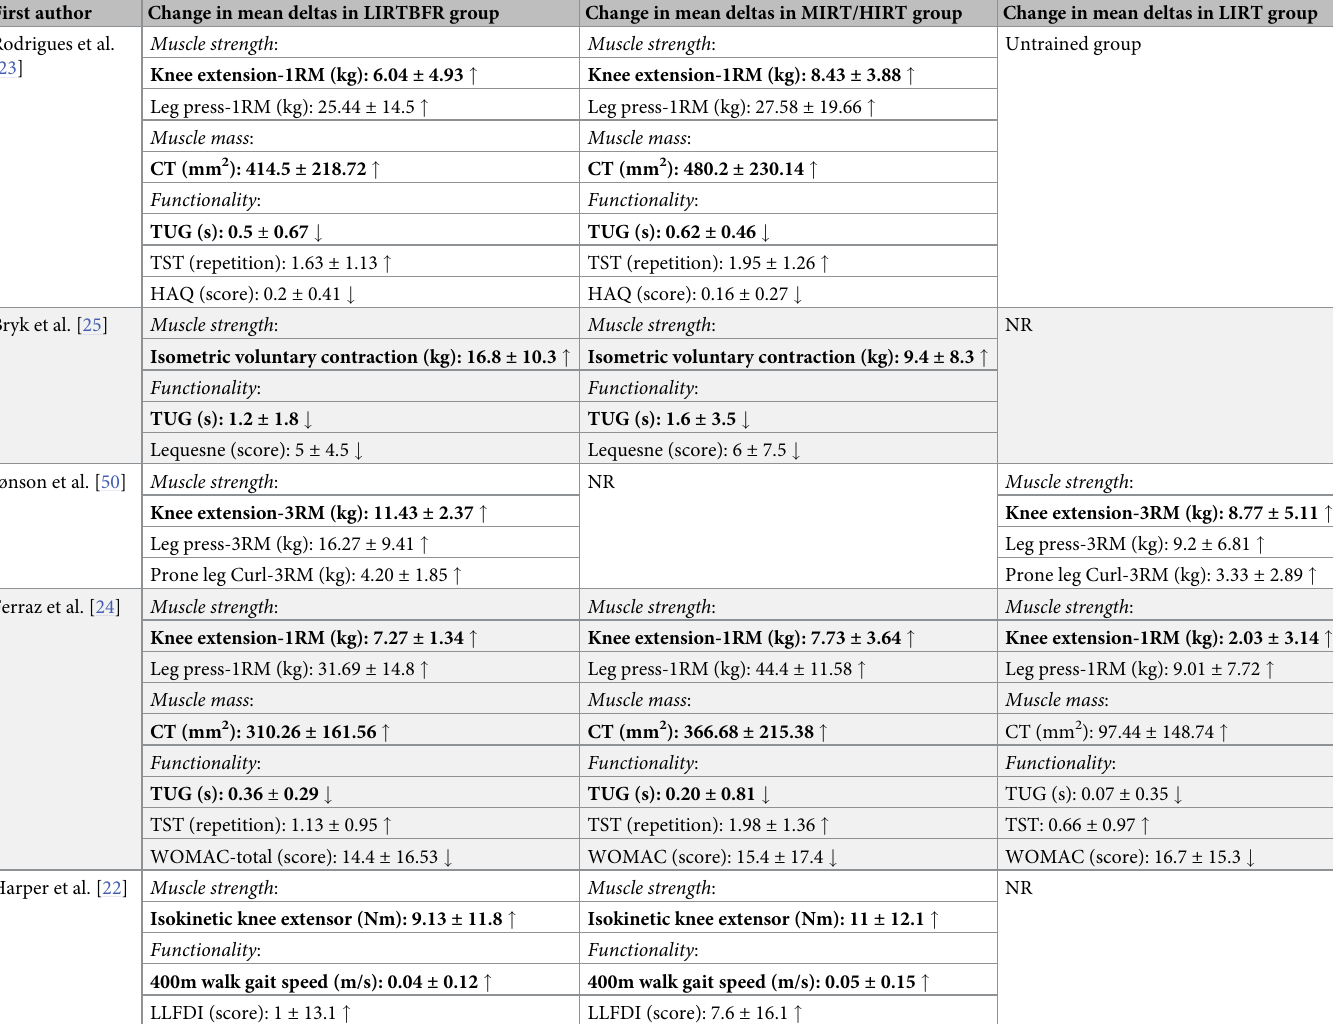
Table 3. Description of changes in mean deltas in muscle strength, muscle mass and functionality among included